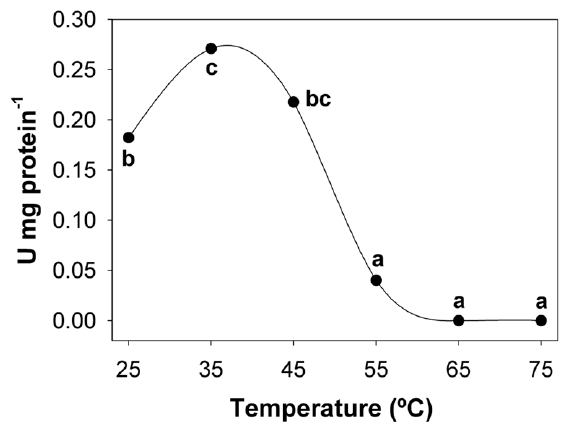
Figure 1. Optimum temperature of intestinal lipases in the common snook C. undecimalis . Different letters indicate significant differences between temperatures. Table 1. Stability at different temperatures of intestinal lipases in the common snook C. undecimalis . ◦